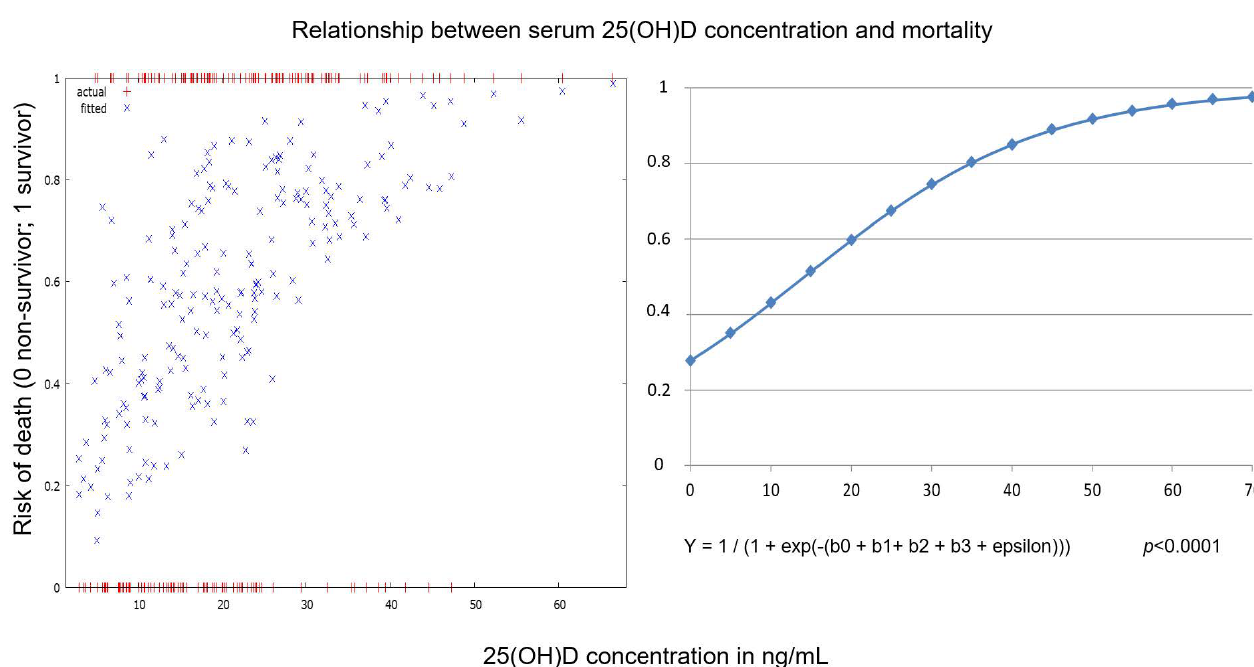
Figure 4. Relationship between serum 25(OH)D concentration upon hospital admission and mortality for the whole cohort of hospitalized patients with COVID-19 pneumonia (patients from both waves analyzed together). Y = dependent variable (risk of death), b1 = independent variable (age), b2 = independent variable (sex), b3 = independent variable (serum25(OH)D concentration).